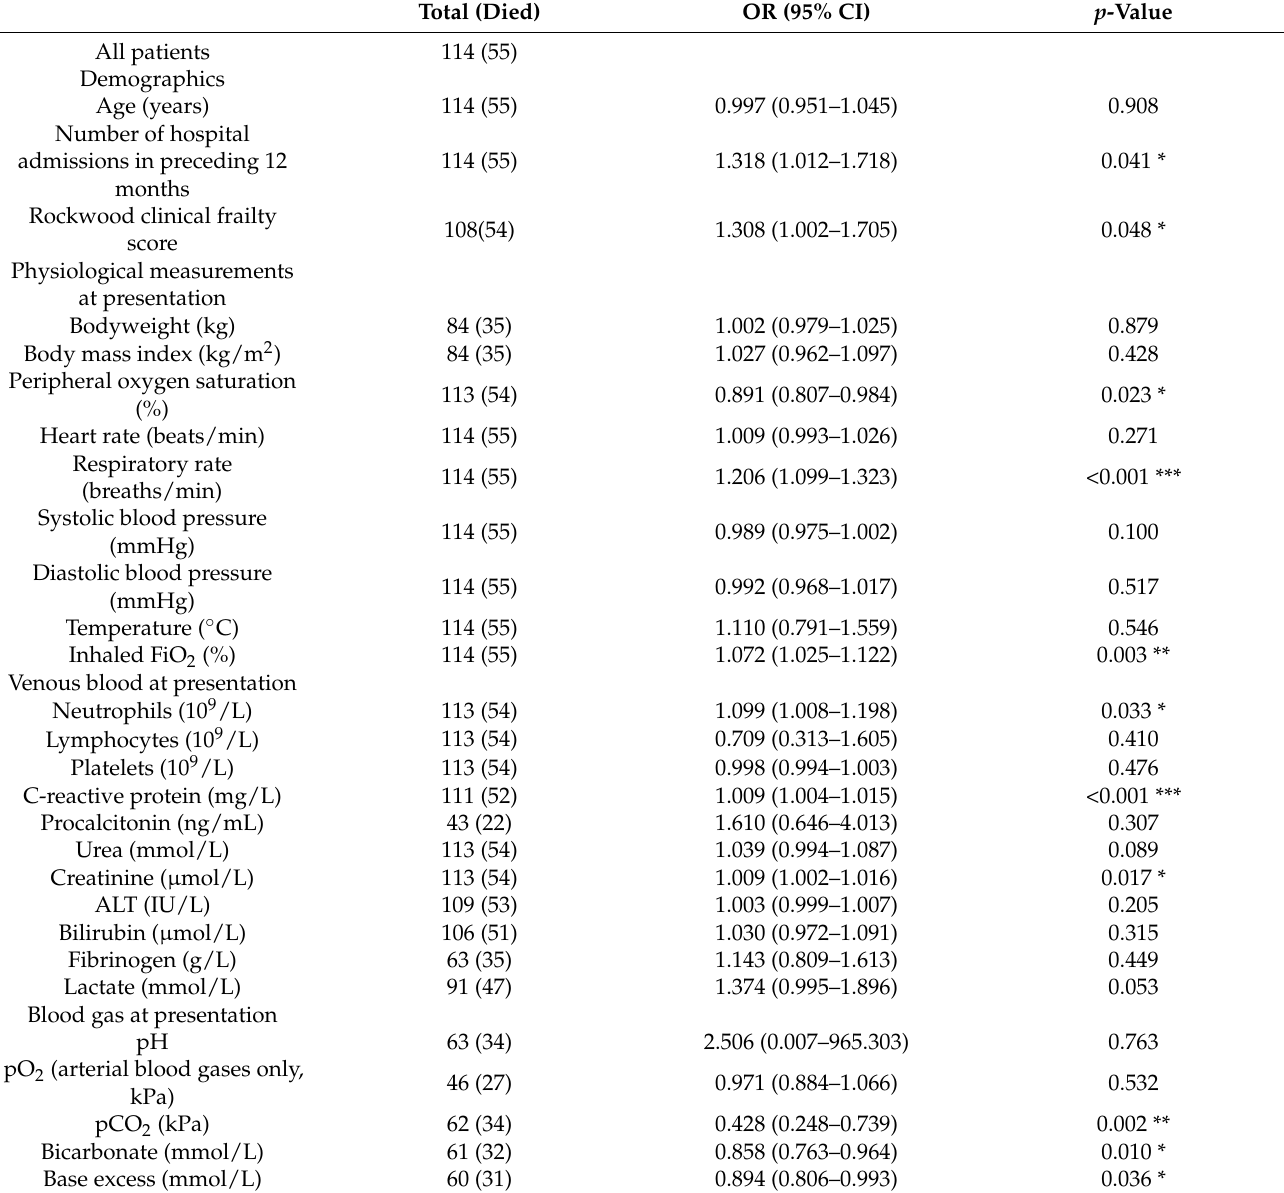
Table 2. Results of univariate logistical regression of continuous variables against inpatient death. All odds ratios given as per unit increase. OR, Odds ratio; CI, Confidence interval. *, p < 0.05; **, p < 0.01; ***, p <